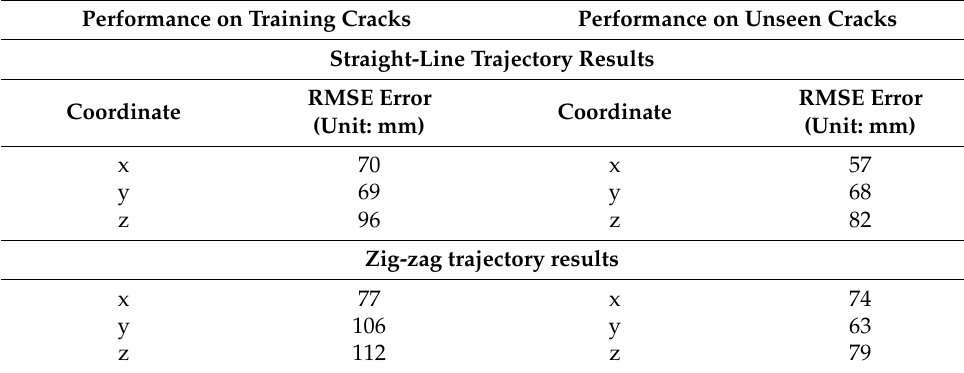
Table 8. Localization accuracy assessment results in terms of RMSE.